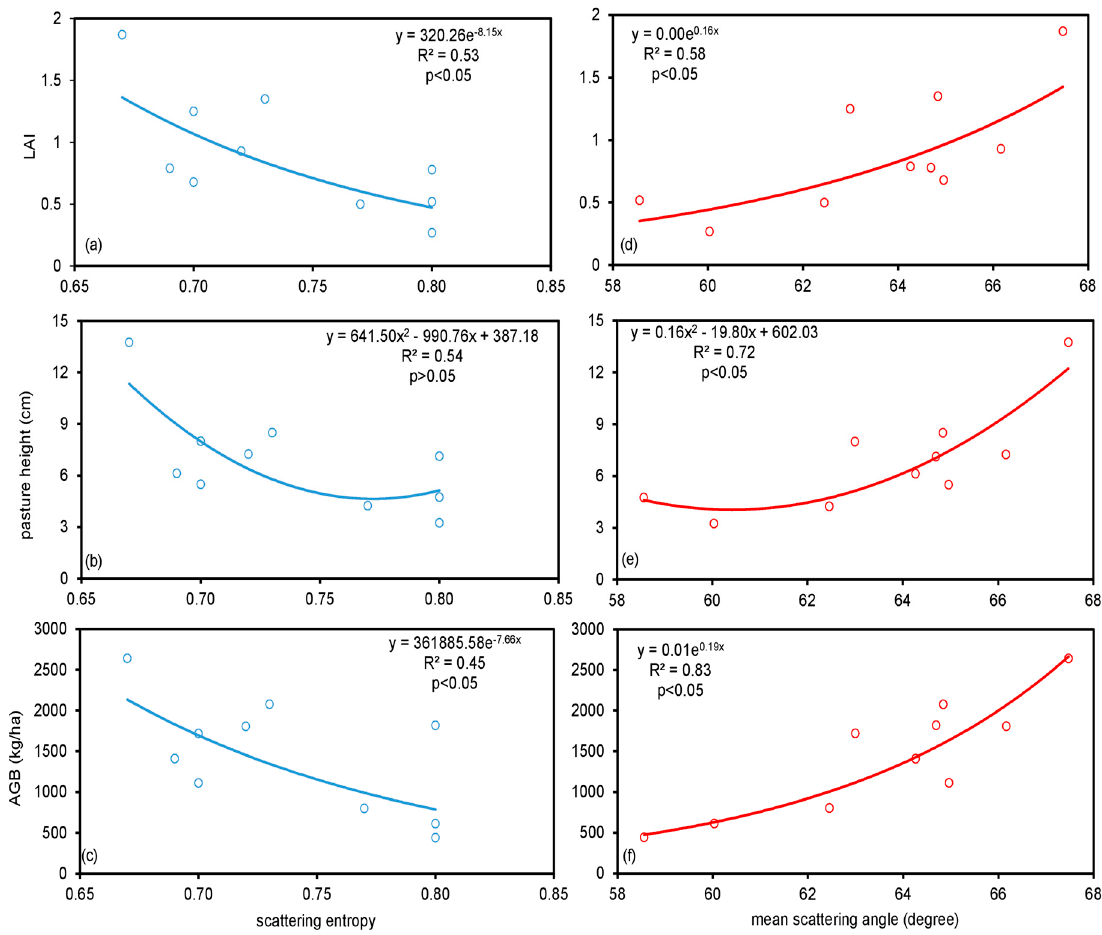
Figure 9. Scatter plots of polarimetric scattering entropy, H ( a – c ) and mean scattering angle, α ( d – f ) as functions of and leaf area index, pasture height (LAI) and aboveground biomass (AGB).